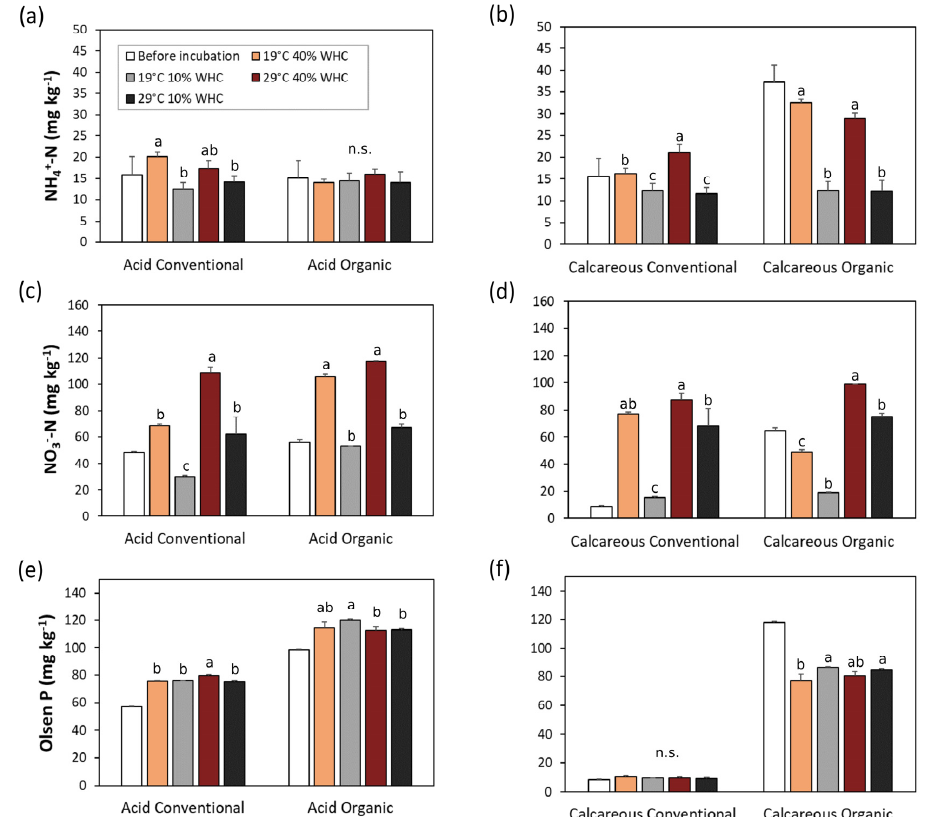
Figure 2. Ammoniacal and nitric nitrogen and Olsen P in soils before and after 6 months’ incubation under no stress (19 °C and 40% WHC), moisture (19 °C and 10% WHC), temperature (29 °C and 40% WHC), and combined stresses (29 °C and 10% WHC). Different letters denote significant differences between treatments within each soil type and management, according to Tukey’s multiple comparison test ( p < 0.05).